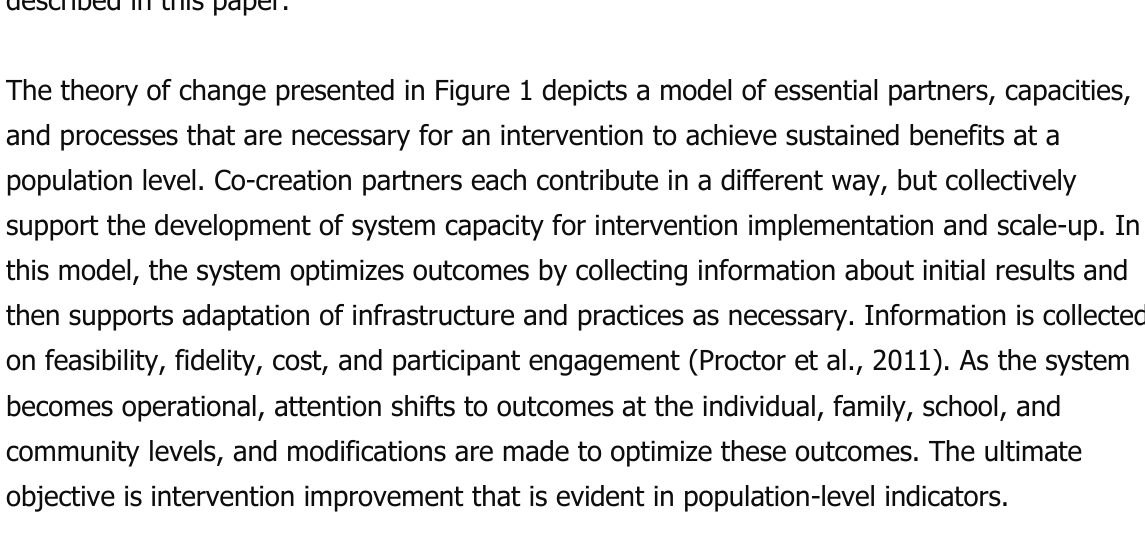
Figure 1. Integrated theory of change for the successful, sustainable scale-up of evidence-based